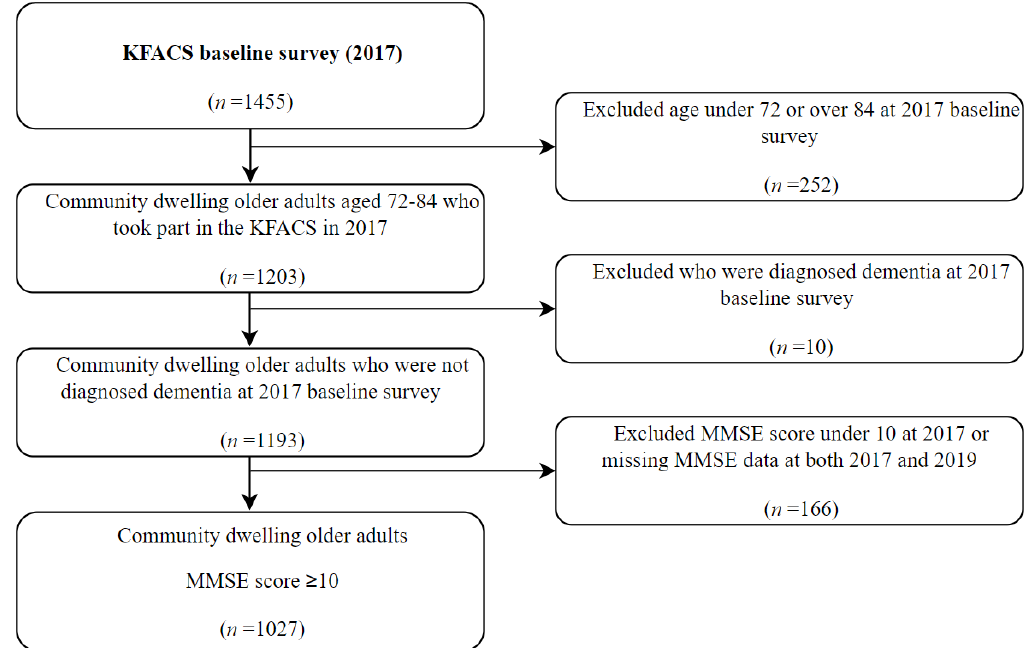
Figure 2. Flowchart of the study population of KFACS 2017 group.